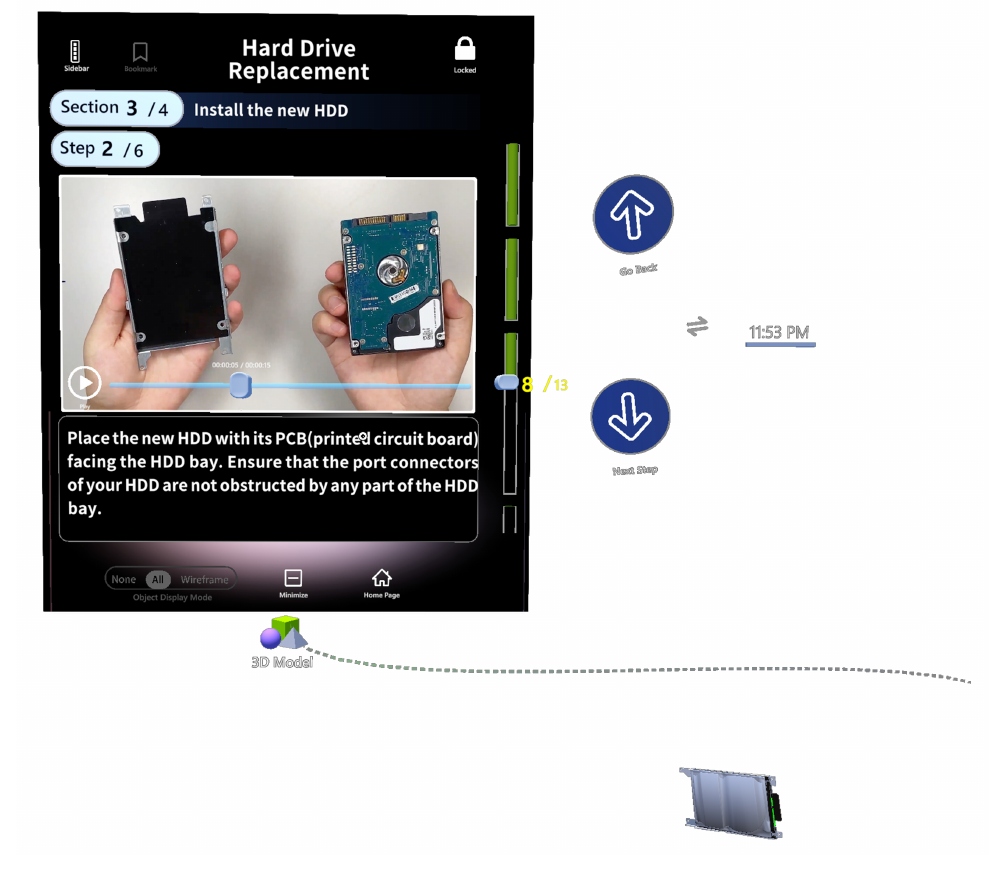
Figure 11. The main-panel after